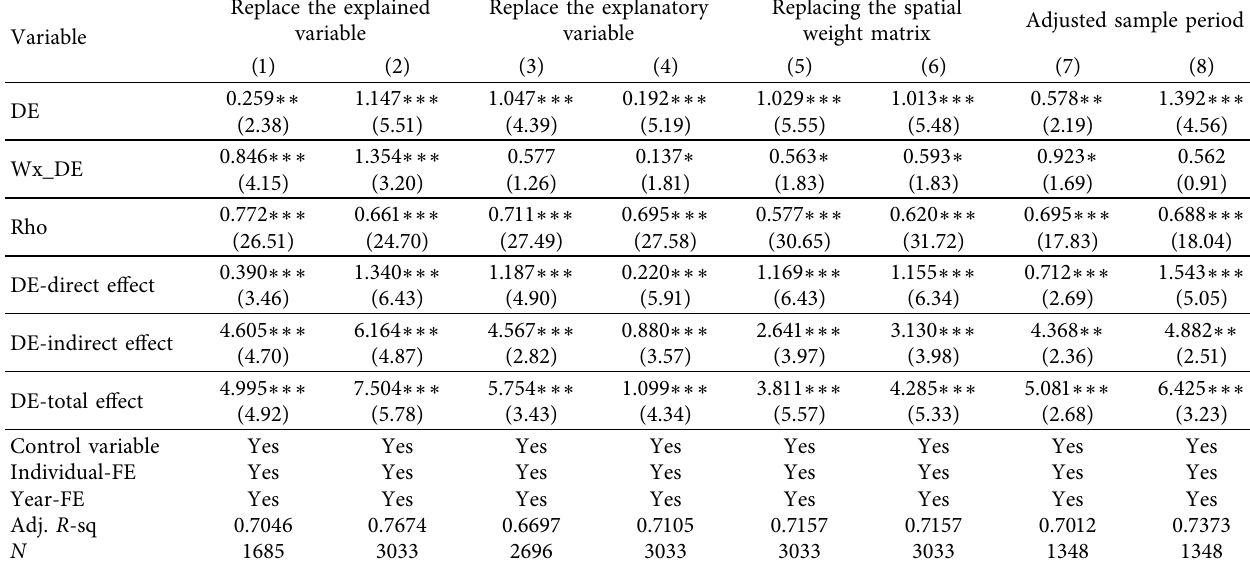
Table 7: Results of the robustness tests for impact of the digital economy on urban